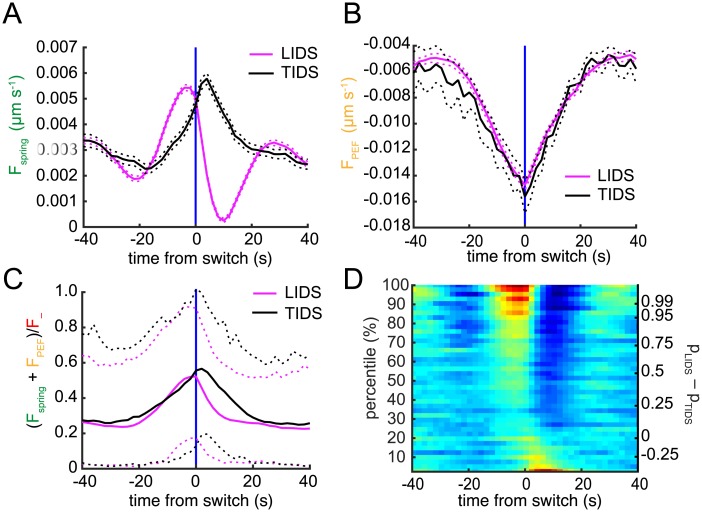
Force profiles during directional switches.Time-dependent estimation of (A) spring force and (B) PEF. Switch events from trajectories where the lead (LIDS, n = 1614; magenta) or trail (TIDS, n = 449; black) kinetochore switched first were aligned at their median switching time (the time origin is marked by vertical blue line). Solid lines indicate mean, dashed lines ±s.e.m.. Forces are given as velocities by rescaling by the viscosity coefficient. (C) Opposing force (spring + PEF) on lead sister during a LIDS (magenta) or TIDS (black) is plotted relative to the depolymerisation force F
−. Solid lines indicate mean, dashed lines 5% and 95% percentiles of the population. (D) Spring force heat map across switching events partitioned by difference between probability of LIDS (p
LIDS) or TIDS (p
TIDS). Events above zero on right y-axis are classified as LIDS; those below as TIDS.